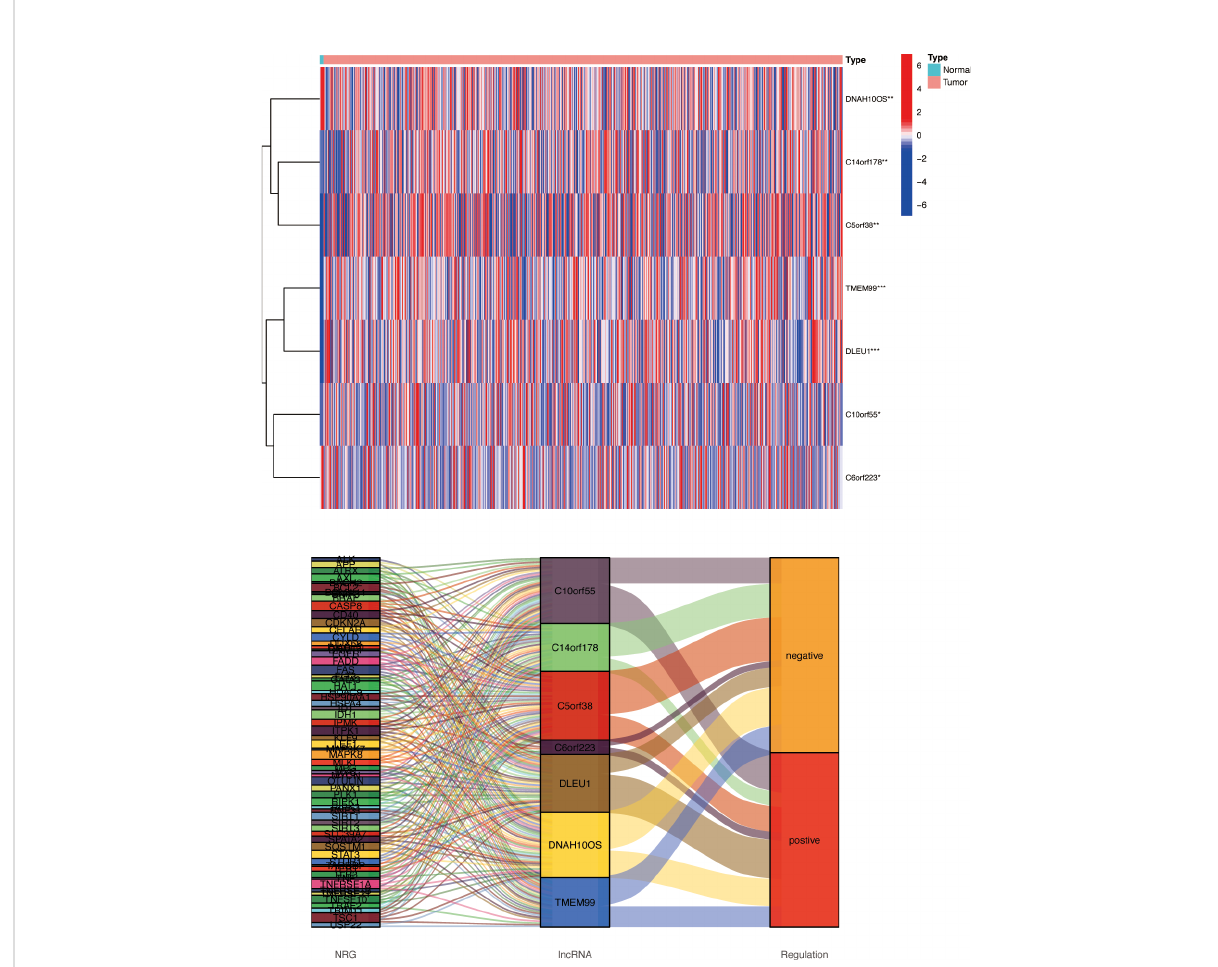
FIGURE 4 Differences in NRlncRNA expression between normal tissue and tumor tissue. Heat map and Sankey map of differentially expressed NRlncRNA. NRlncRNA, necroptosis-related long non-coding RNA. * if p < 0.05, ** if p < 0.01, and *** if p <